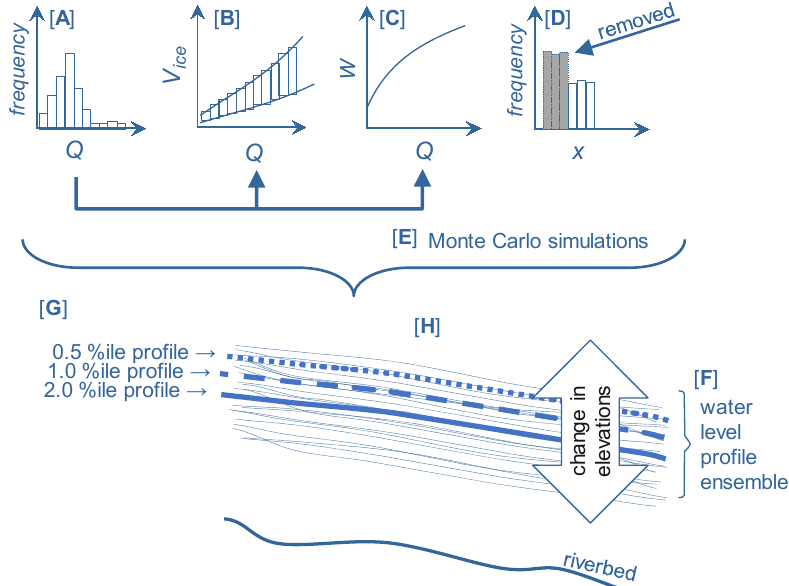
Figure 20. Adjustment in the boundary condition frequency distribution within the stochastic modelling framework when considering mitigation options, such as artificially breaking the ice cover to hinder ice-jam lodgments; explanations for each subfigure are provided in the main text (drawn by the first author).